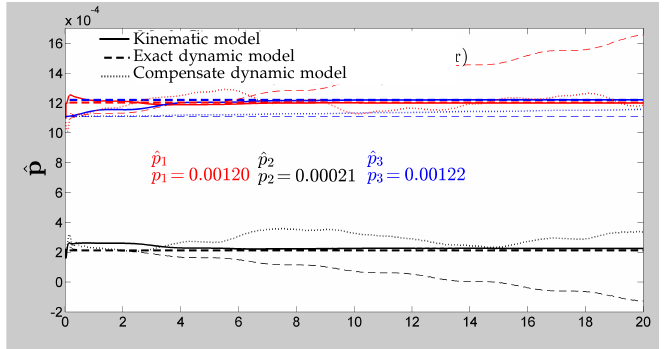
Figure 8. The vision parameters estimated for the following task. Figures 9 and 10 show the norm of the speed control error of the adaptive dynamic controller and the convergence of the dynamic parameters of the robot, respectively.